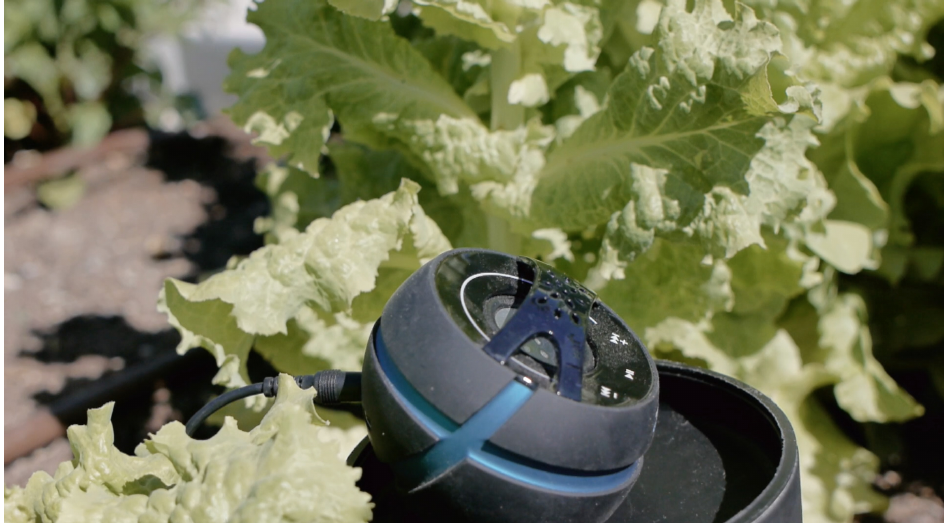
Figure 2. A loudspeaker embedded in a raised bed in which lettuce is being